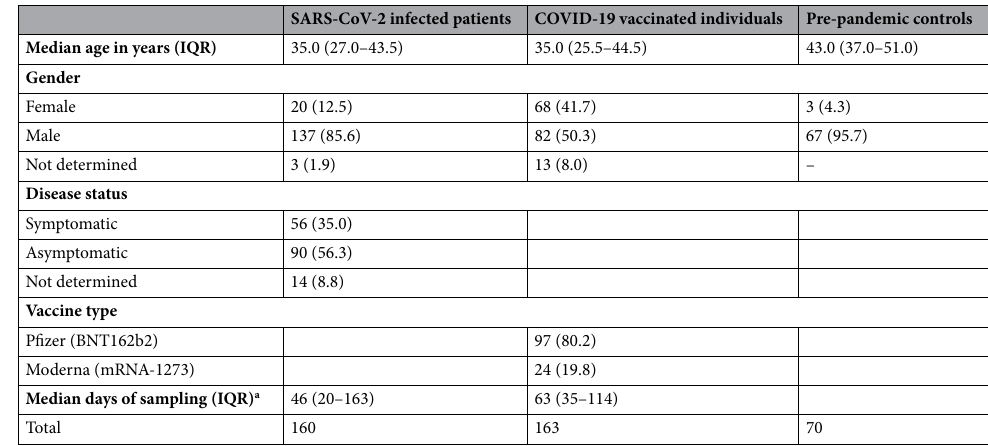
Table 1. Demographic and clinical characteristics of samples collected from SARS-CoV-2 infected cohort (n = 127), vaccinated cohort (n = 121), and controls (n = 70). a Median days of sampling post symptoms onset or RT-PCR positive test for SARS-CoV-2 infected cohort or post-second dose administration for the vaccinated cohort. SARS-CoV-2: severe acute respiratory syndrome virus 2, COVID-19: Coronavirus Disease 2019. IQR interquartile range.